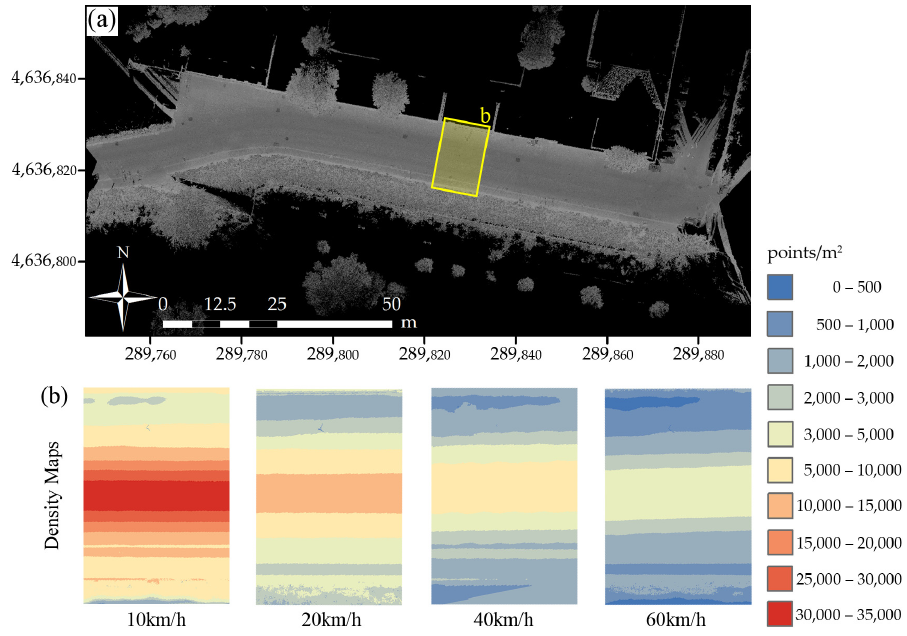
Figure 10. Density map. ( a ) Top view of the point cloud, the color scale is a function of the intensity values; ( b ) excerpts of the density maps at different average velocities (10, 20, 40, 60 km/h).